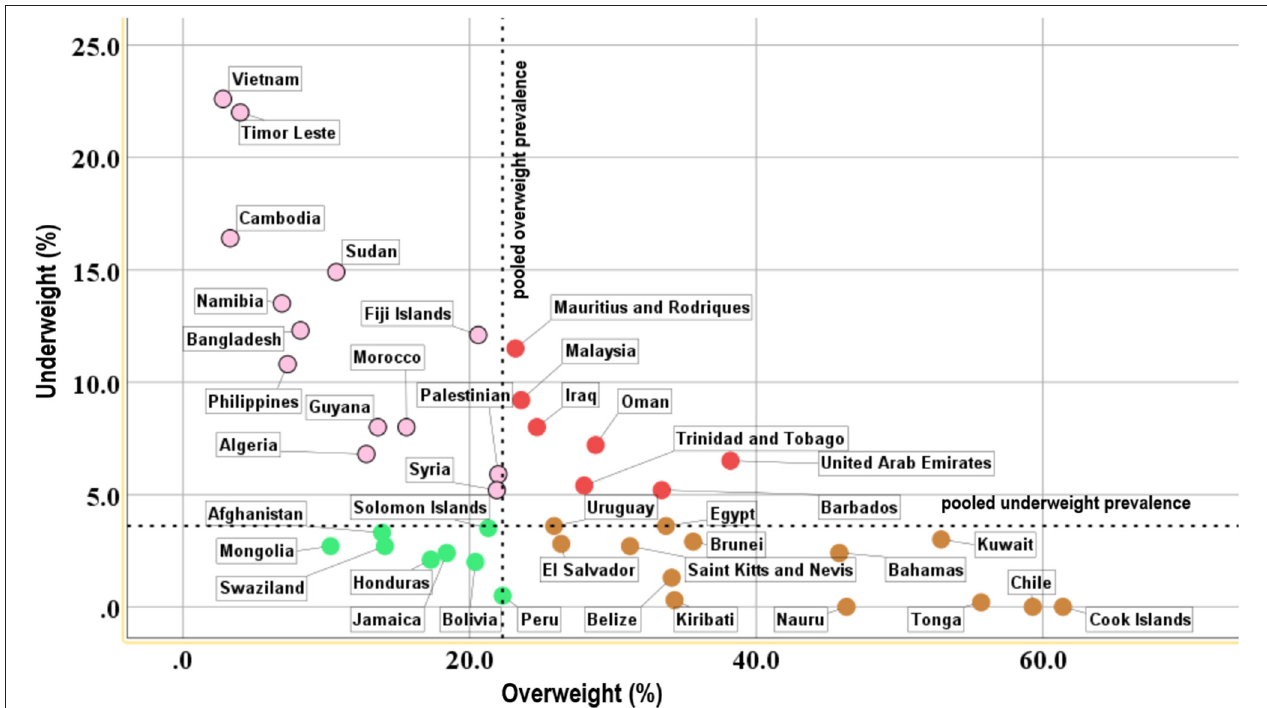
FIGURE 2 | Scatterplot showing the relationship between the proportion of overweight and underweight adolescents with hunger aged 12–15 years, organized by